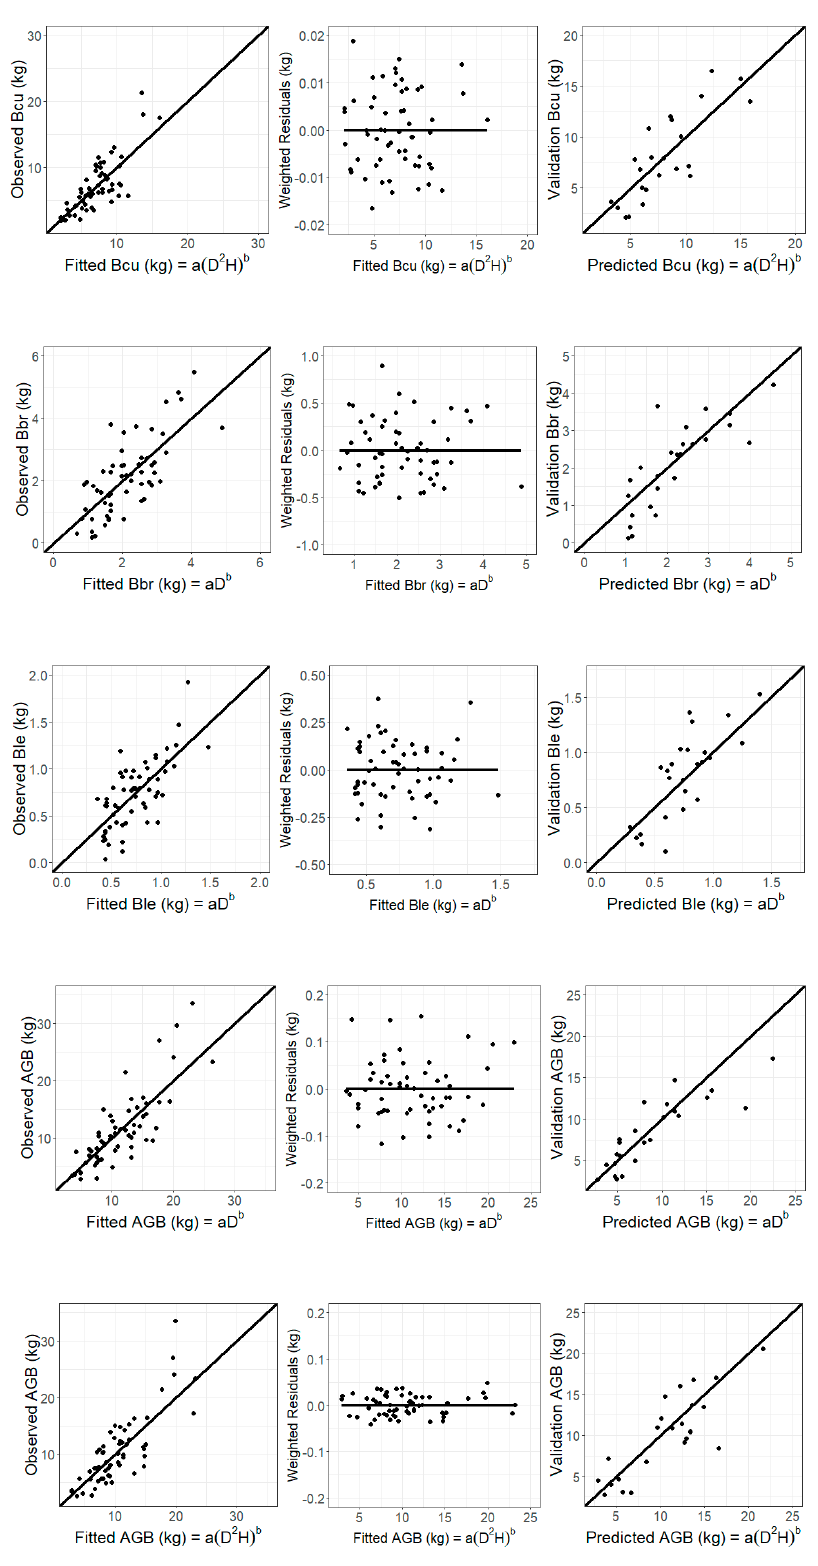
Figure 4. Plots of separate selected models for bamboo aboveground biomass ( AGB ) and its components with different predictor(s): Left: Observed was randomly split from 70% dataset vs. weighted fitted biomass; Middle: Maximum likelihood weighted residuals vs. fitted biomass; and Right: Validation data was randomly split from 30% dataset vs. predicted biomass. Bcu , Bbr , Ble , and AGB are biomass of bamboo culm, branches, leaves, and total aboveground biomass,